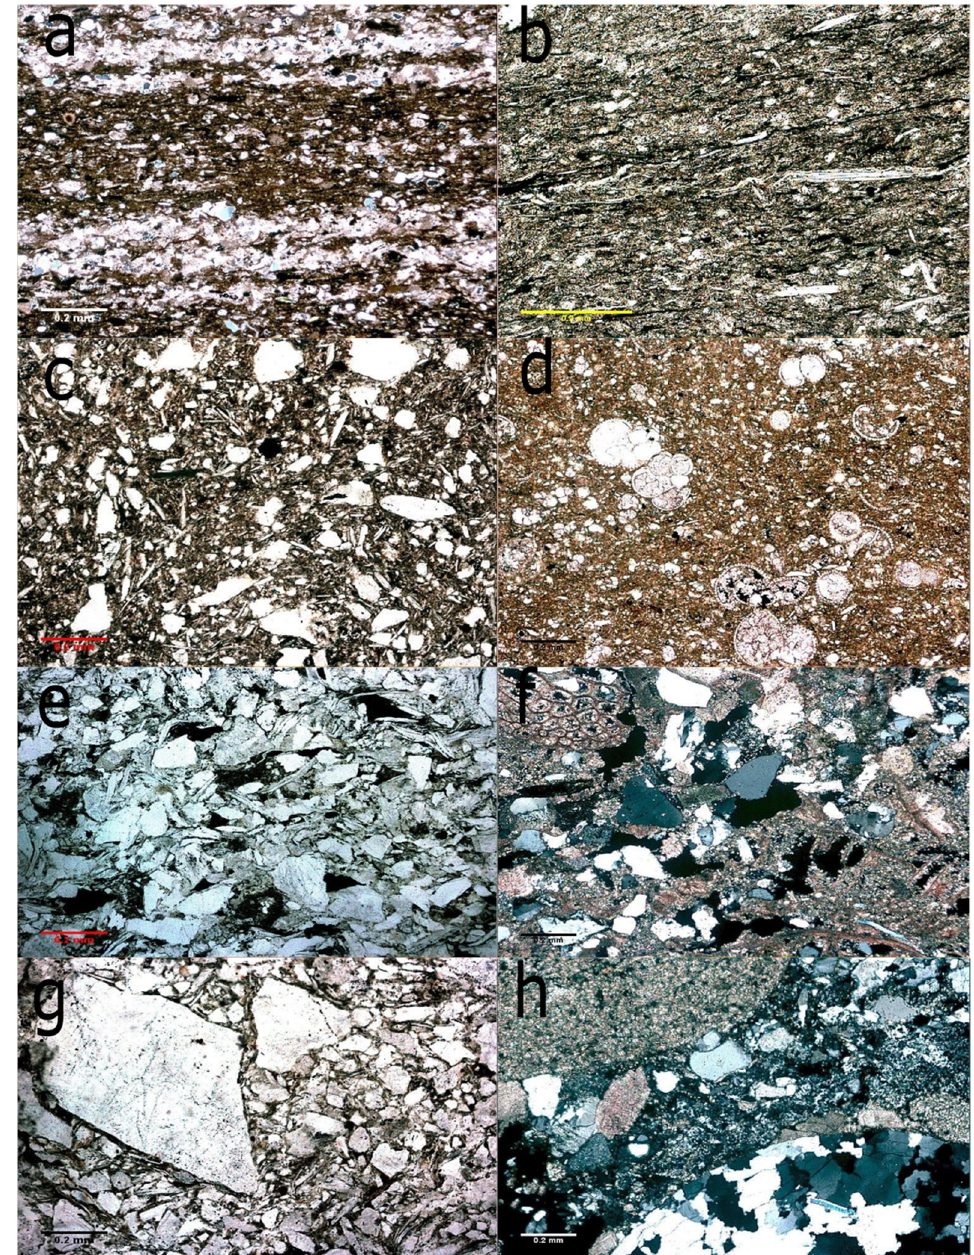
types of petromictic conglomerates as well.